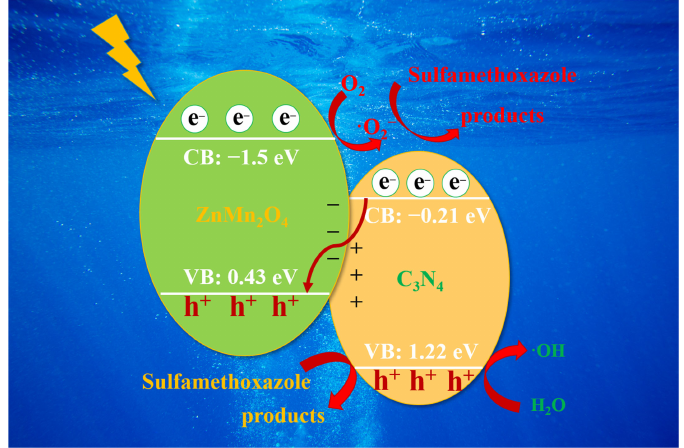
Figure 9. The schematic diagram of photocatalytic pollutant degradation by ZMOCN ‐ 50 wt%.